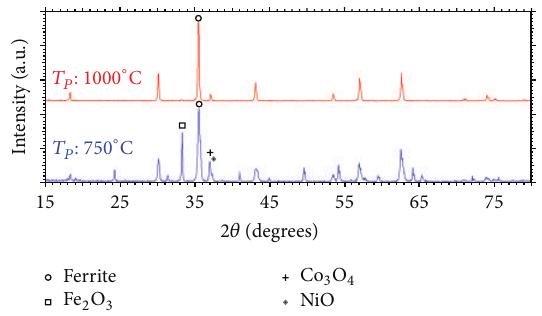
Figure 1: X-ray diffraction patterns of the prefired samples.